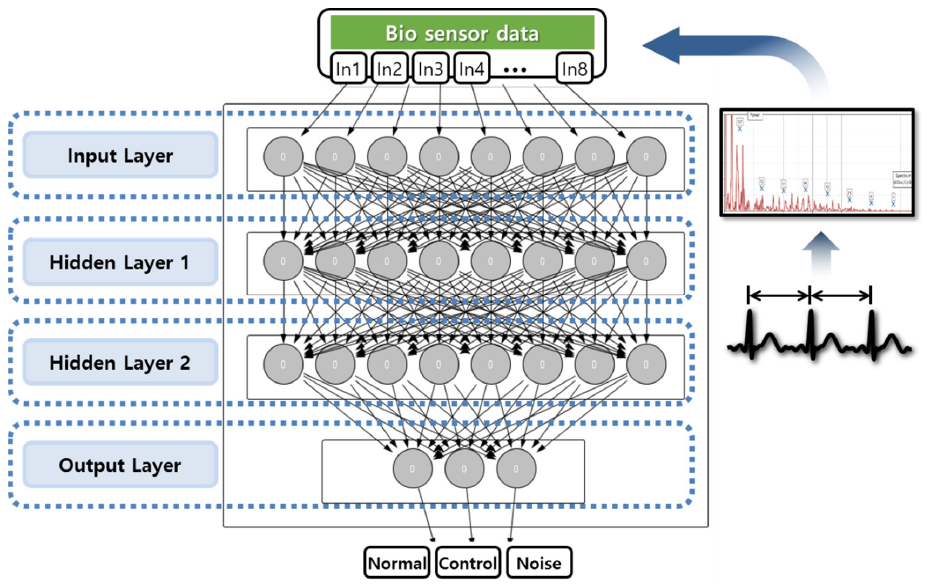
Figure 5. Internal structure of deep neural network model.